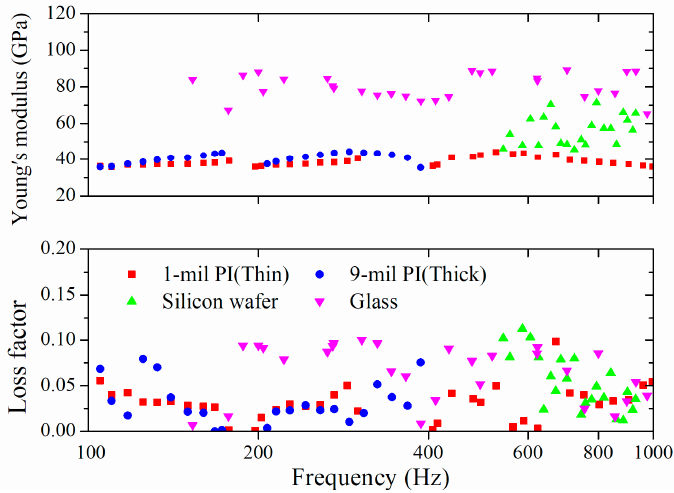
Figure 6. Young’s moduli and loss factors of the inkjet-printed Ag film on various substrates.